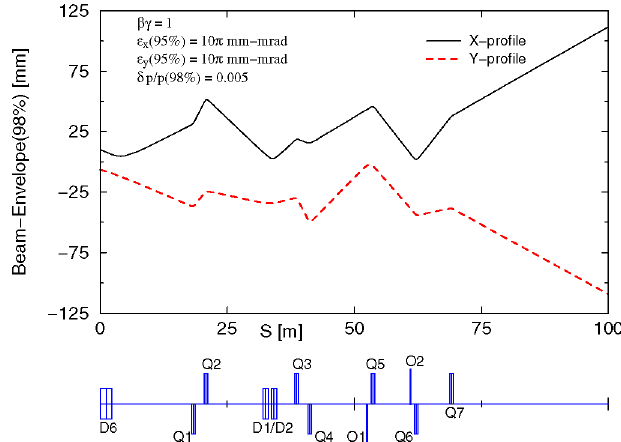
FIG. 4. (Color) Half of the horizontal (black solid line) and half of the vertical (red dashed line) beam profile of the beam trans- ported down the NSRL line. The beam profiles contain 98.5% of the beam’s intensity. As in Fig. 3, the main magnetic elements of the line with their names appear at the bottom of the plot.